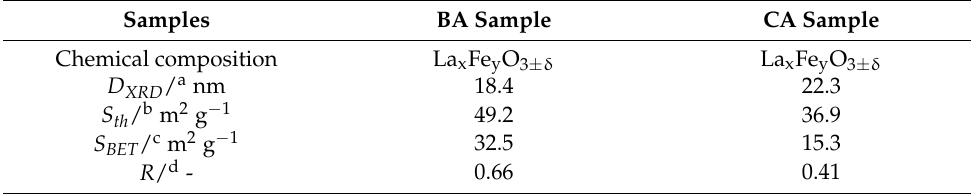
Table 1. Selected physico-chemical characteristics obtained for BA and CA catalysts.